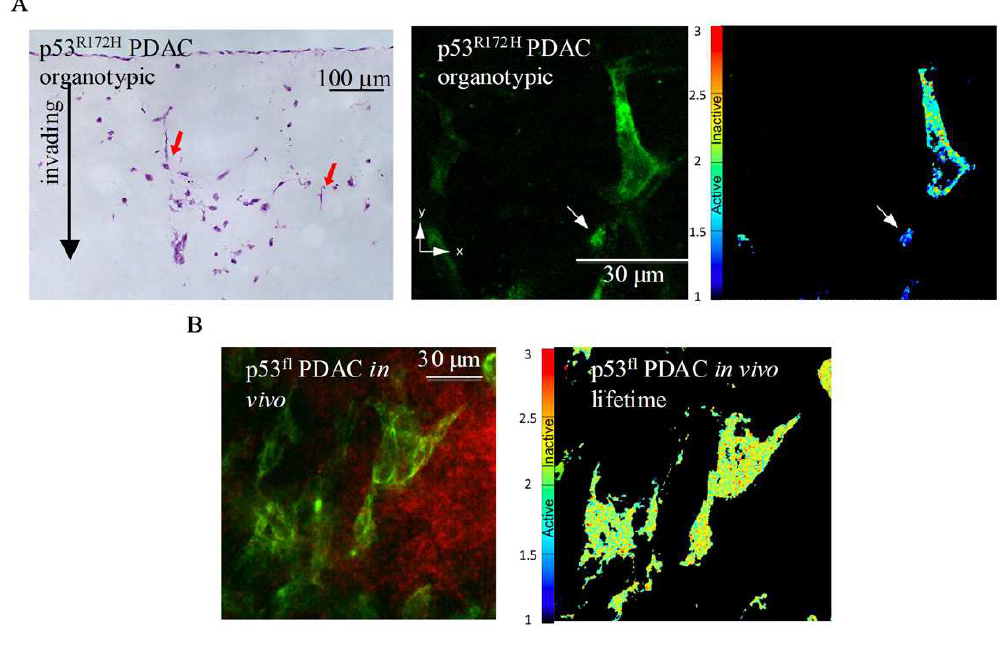
Figure 8. Protein activity monitored by multiphoton-based FLIM-FRET in 3D organotypic assays and in vivo live mouse model. ( A ) Left panel: H&E-stained sections of mutant p53 R172H -driven PDAC cell invasion within collagen Ι /fibroblast organotypic matrix culture. Middle panel: Representative fluorescence images of mutant p53 R172H cells expressing the Raichu-RhoA reporter (green) within the matrix during invasion (~150 µm). Right panel: Corresponding life-time map of RhoA activity in mutant p53 R172H cells in the presence of a chemotactic gradient. Red arrows indicate representative cells examined at depth by multi-photon based FLIM-FRET. Low basal RhoA activity is represented in the life-time color maps with red/yellow colors, while high RhoA activity is represented as blue on the color map. ( B ) Protein activity monitored by multiphoton-based FLIM-FRET in vivo . Left panel: p53 fl PDAC cells expressing the RhoA-Raichu reporter (green) within a tumor. Blood vasculature is highlighted by tail vein injection of Qtracker 655 quantum dots (red). Right panel: Corresponding life-time map of RhoA activity in vivo